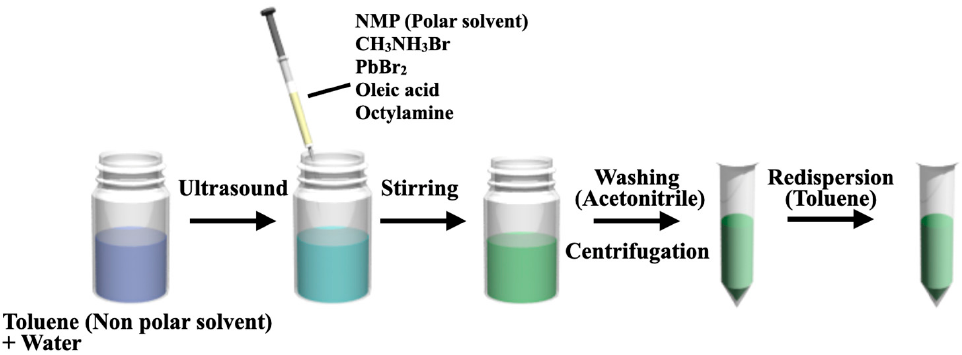
Figure 1. Schematic illustration of preparing MAPbBr 3 PeQDs by water-assisted